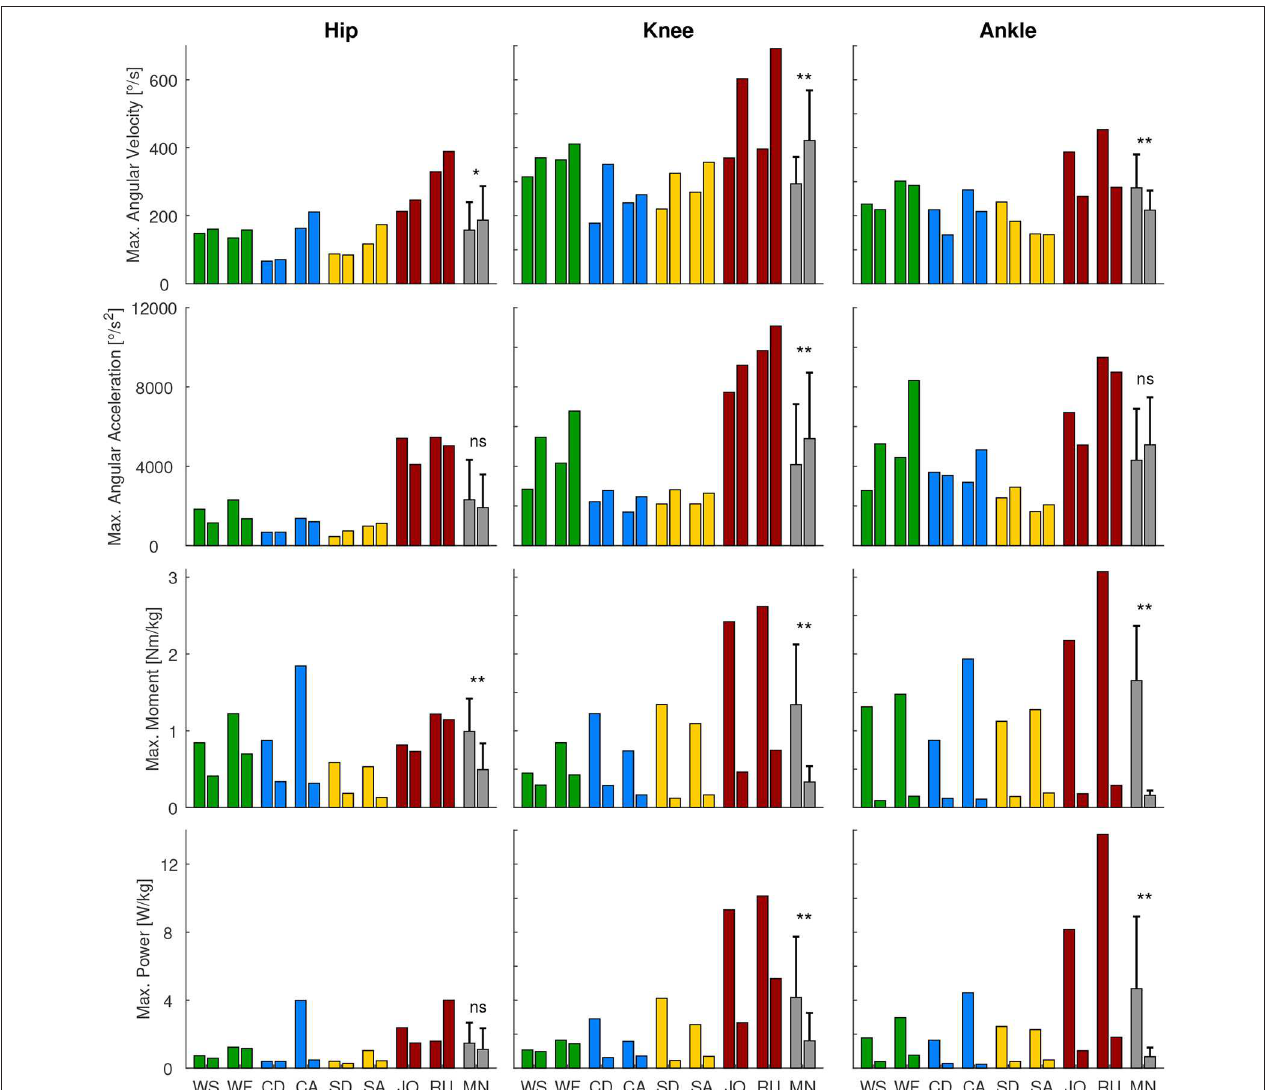
FIGURE 3 | Maximum angular velocity, angular acceleration, moment, and power for the hip, knee, and ankle for the gait related movements [walking slow (WS), walking fast (WF), climbing descend (CD), climbing ascend (CA), stair descend (SD), stair ascend (SA), jogging (JO), and running (RU)]. For comparison of the maxima of stance (left bar) and swing phase (right bar), the mean over these conditions (MN, gray bars) and the statistical difference was determined. * p < 0.05, ** p < 0.01, ns,